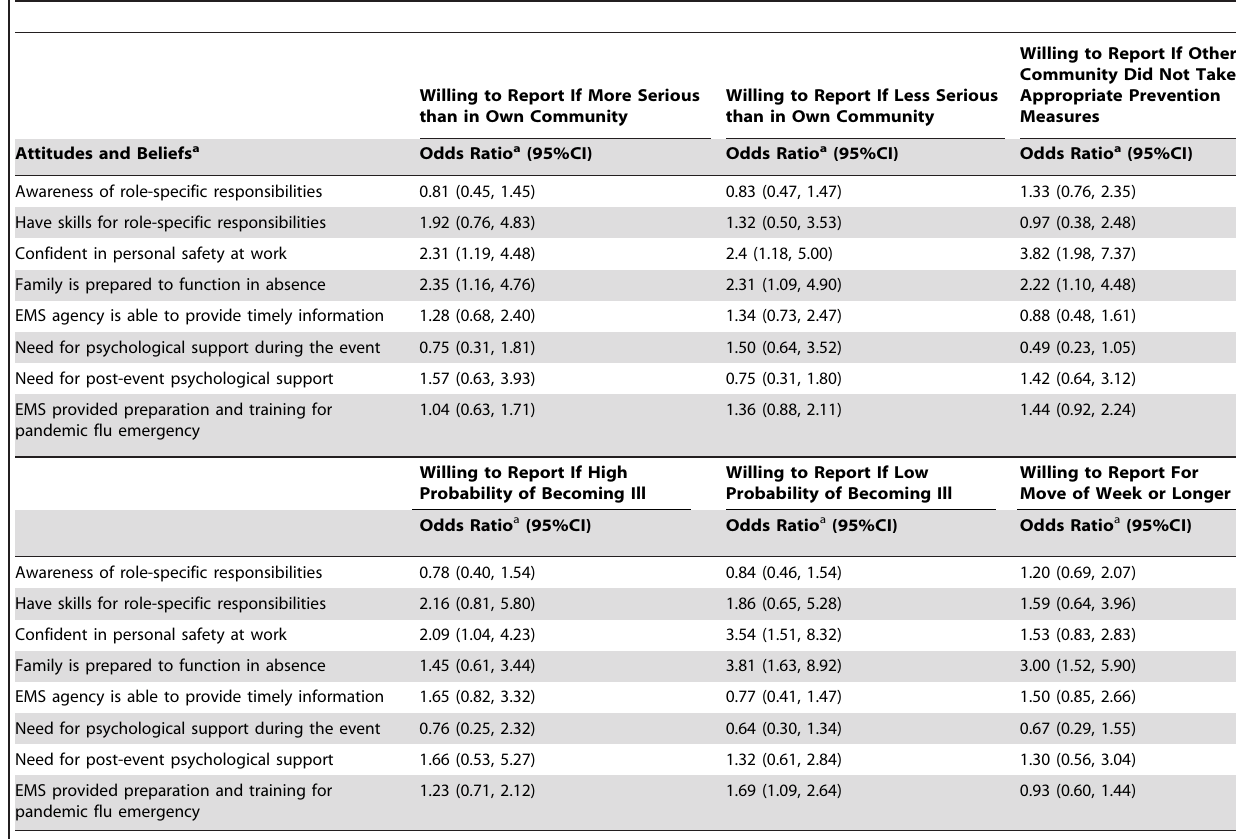
Table 6. Weighted multivariate logistic regression analyses to evaluate the associations between willingness-to-report scenarios in another community and selected attitudes and beliefs regarding a pandemic influenza emergency (adjusted for other